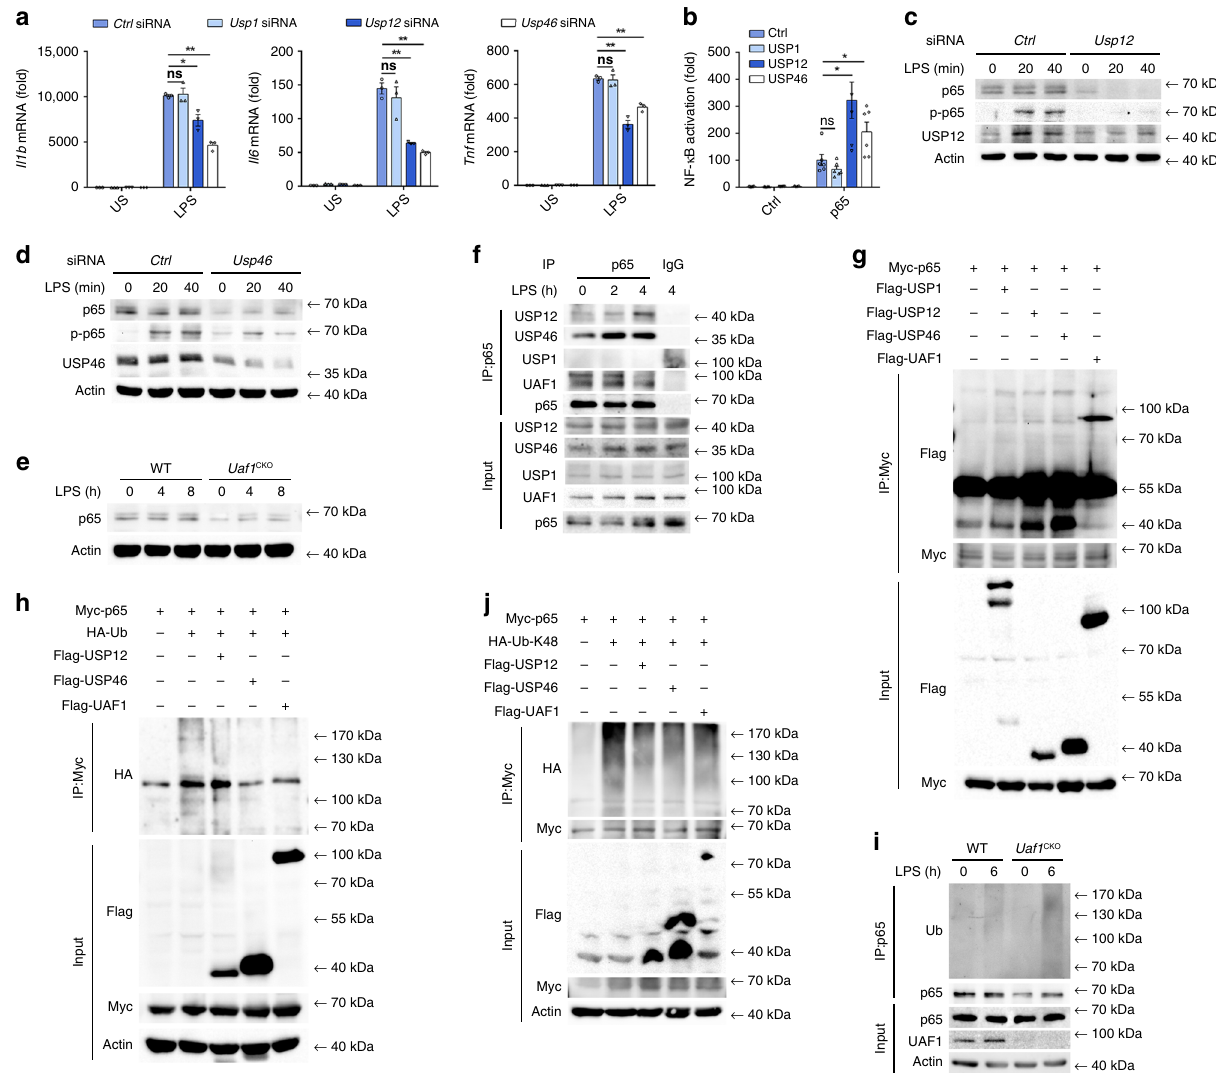
Fig. 4 UAF1/USP12 and UAF1/USP46 complexes promote NLRP3 transcription. a RT-PCR analysis of Il1b , Il6 and Tnf mRNA expression in Ctrl siRNA − , Usp1 siRNA − , Usp12 siRNA − , or Usp46 siRNA-transfected mouse peritoneal macrophages, followed by stimulation with LPS for 2 h (mean ± SEM, two- tailed t-test Usp1 siRNA, Usp12 siRNA and Usp46 siRNA vs. Ctrl siRNA, left panel: ns = 0.8310, * P = 0.0135, ** P < 0.0001 in sequence, middle panel: ns = 0.4945, ** P = 0.0006, 0.0003 in sequence, right panel: ns = 0.8037, ** P = 0.0005, 0.0007 in sequence; n = 3 indepe n dent experiments). b Analysis of NF- κ B reporter activation using a Luciferase assay in HEK293T cells transiently transfected with the indicated plasmids (mean ± SEM, two-tailed t -test USP1, USP12 and USP46 plasmids vs. empty control plasmid, ns = 0.1774, * P = 0.0106, 0.0298 in sequence; n = 6 indepe n dent experiments). c , d Western blot analysis of p65 or p-p65 in Ctrl siRNA-, Usp12 siRNA-, or Usp46 siRNA-transfected mouse peritoneal macrophages followed by stimulation with LPS for the indicated time periods. e Western blot analysis of p65 in WT or Uaf1 de fi cient mouse peritoneal macrophages after stimulation with LPS for the indicated time periods. f Cell lysates of mouse peritoneal macrophages stimulated with LPS for the indicated time periods were subjected to immunoprecipitation (IP) with anti-p65, followed by western blot analysis with antibodies to UAF1, USP1, USP12, USP46, or p65. Proteins from a whole-cell lysate were used as a positive control (Input). g Cell lysates of HEK293T cells transiently transfected with Myc-p65, Flag-USP1, Flag-USP12, Flag-USP46, and Flag-UAF1 were subjected to IP using Myc antibody, followed by western blot analysis with anti-Myc or anti-Flag. h , j Cell lysates of HEK293T cells transiently transfected with Myc-p65, HA-Ub, or HA-tagged K48-linked ubiquitin (HA-K48-Ub), Flag-USP12, USP46, and Flag-UAF1 were subjected to IP with Myc antibody, followed by western blot analysis with anti-HA. i Western blot analysis of extracts from LPS-stimulated WT or Uaf1 CKO